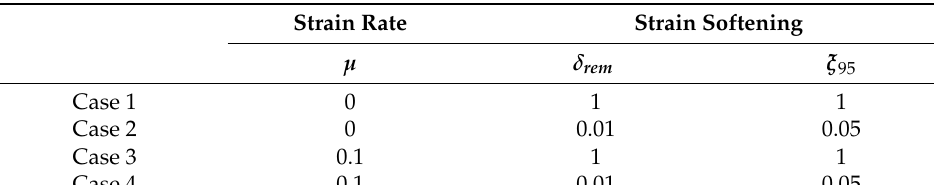
Table 1. Strain-rate and strain-softening parameters.